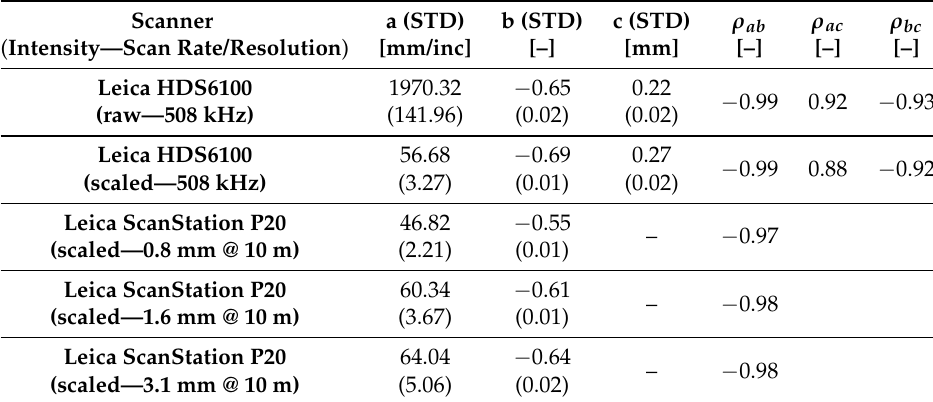
Table 1. Estimated parameters of Equation (5) with standard deviation.